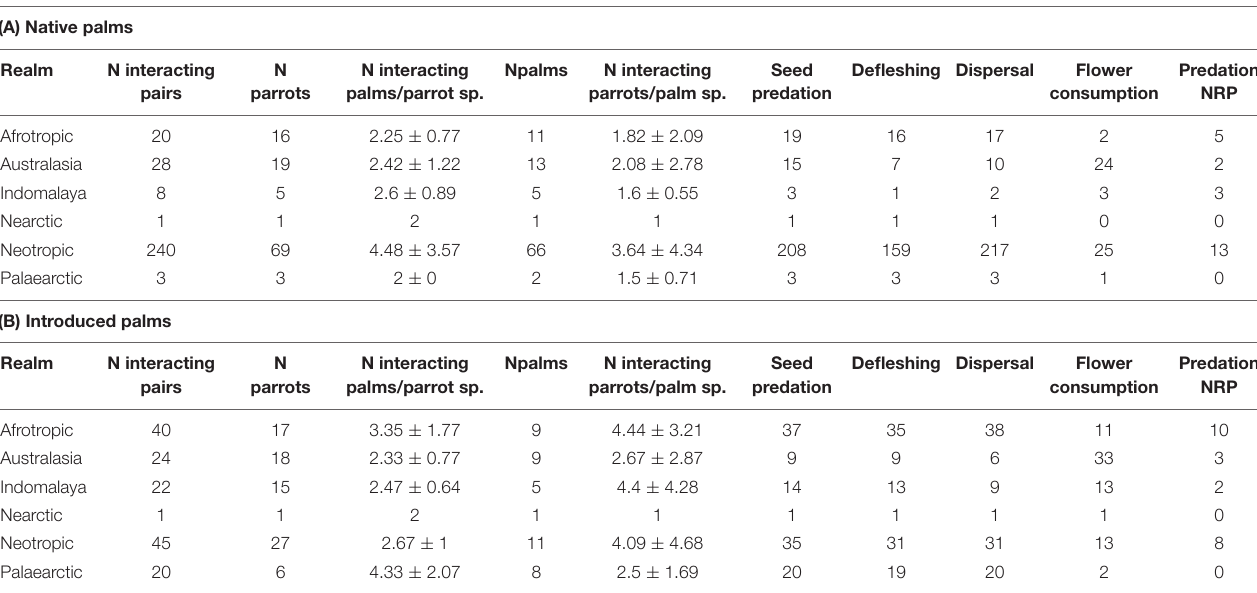
TABLE 2 | Number of parrot and palm species (N parrots and N palms, respectively), mean ( ± SD) number of palms involved in interactions per parrot species and vice versa (N interacting palms/parrot sp. and N interacting parrots/palm sp. respectively) and total number of interactions recorded across realms, considering whether the palm species were native (A) or introduced (B)